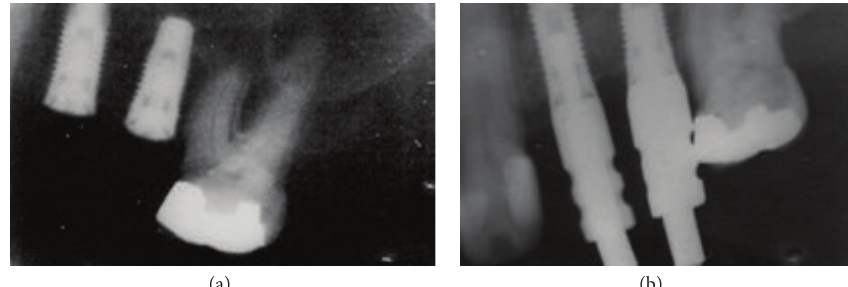
Figure 4: Periapical radiograph four months after surgery (a) and connection of the abutments (b) (March 2009).